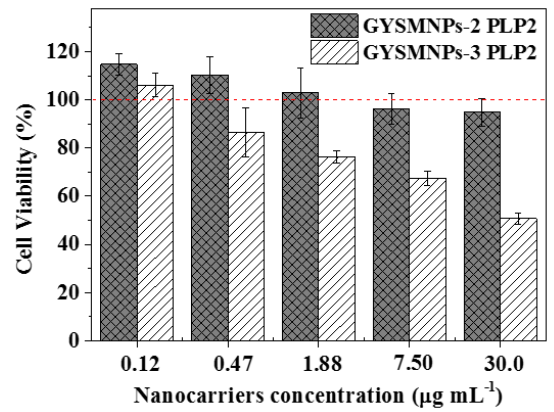
Figure 7. The in vitro biocompatibility study of GbMNPs in the primary cell culture (PLP2). Error bars represent a 95% confidence interval.